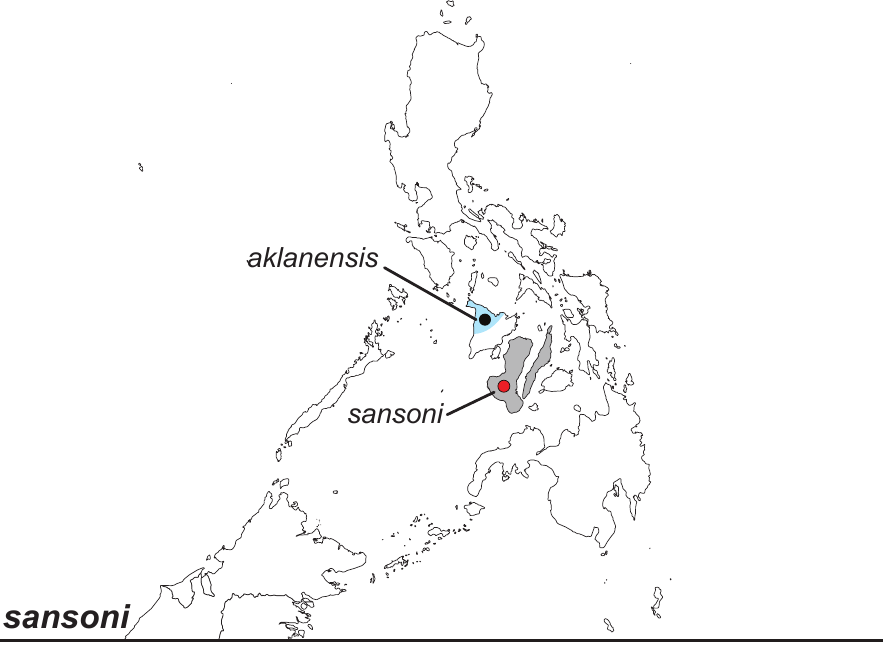
Figure 63. Distribution map of Elymnias sansoni .